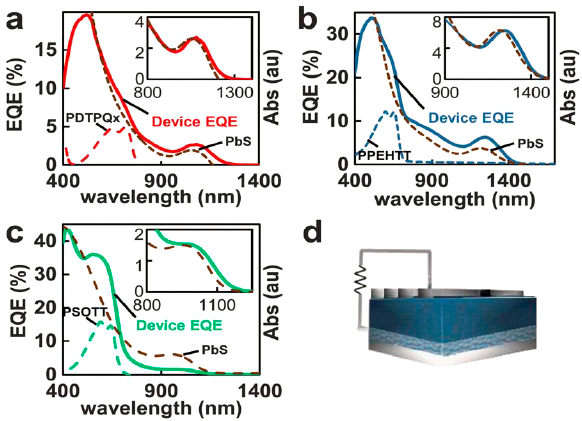
Figure 5. ( a – c ) Absorbance spectra (dashed line) of different conjugated polymers and PbS QDs used in the blend, and their corresponding EQE. Insets are a magnified view of the IR region of the spectra. ( d ) Schematic of the design of a QD/polymer hybrid device. Reproduced from [34] with permission of the Royal Society of Chemistry.